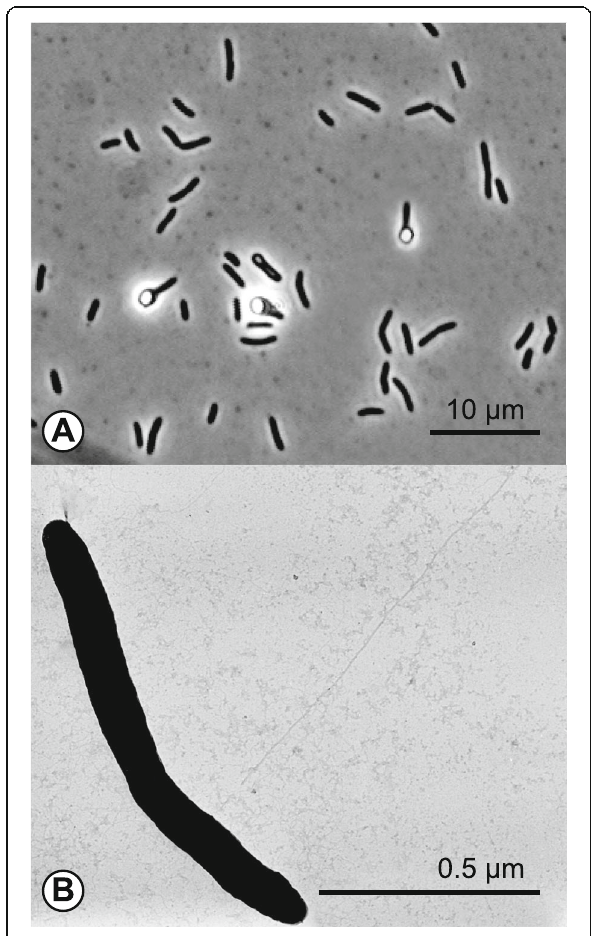
Fig. 1 Morphology of D. alkaliphilus AHT1 T . a Phase contrast micrograph of cells. b Electron microscope image of a D. alkaliphilus AHT1 T